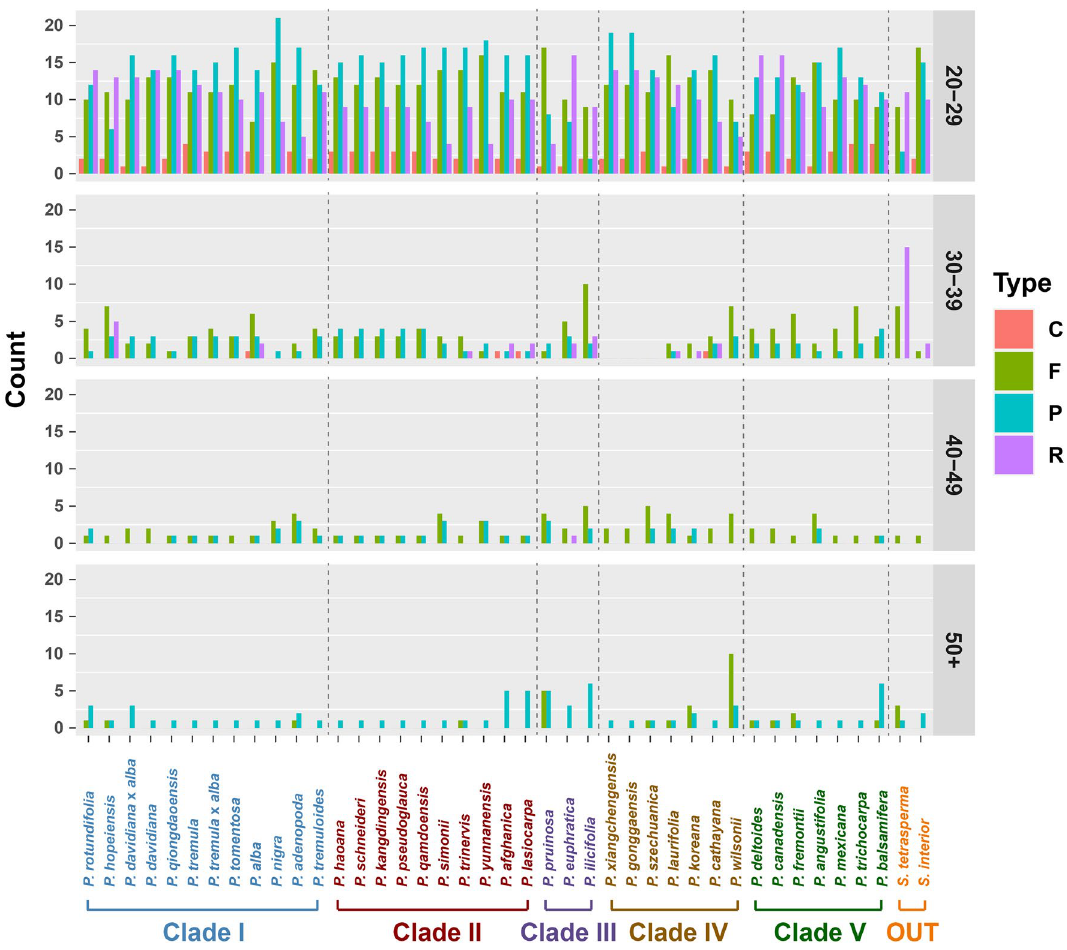
Figure 3. Variation of repeat abundance and type within chloroplasts from 39 Populus species and two